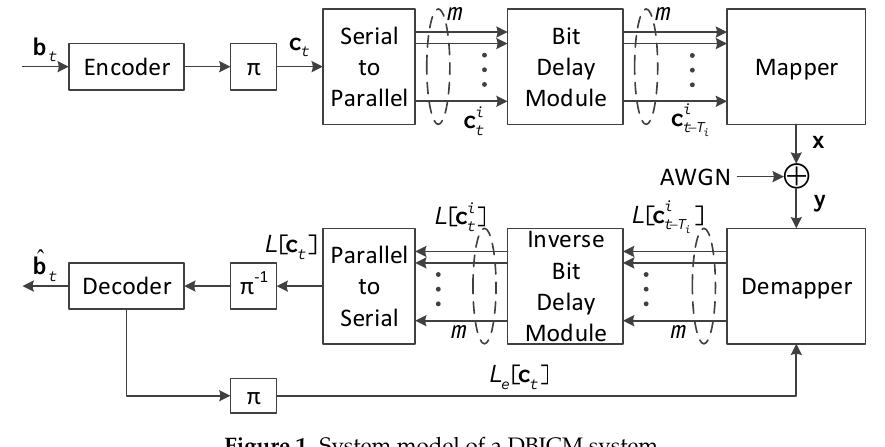
Figure 1. System model of a DBICM